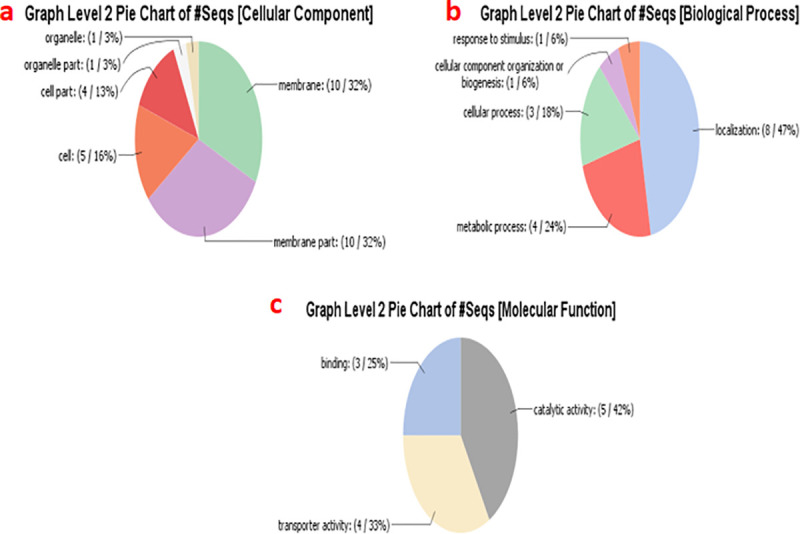
Graphical representation of categories of Gene Ontology (GO) terms of identified MTA related to Spot blotch: a) Cellular Component b) Biological Process c) Molecular Function.